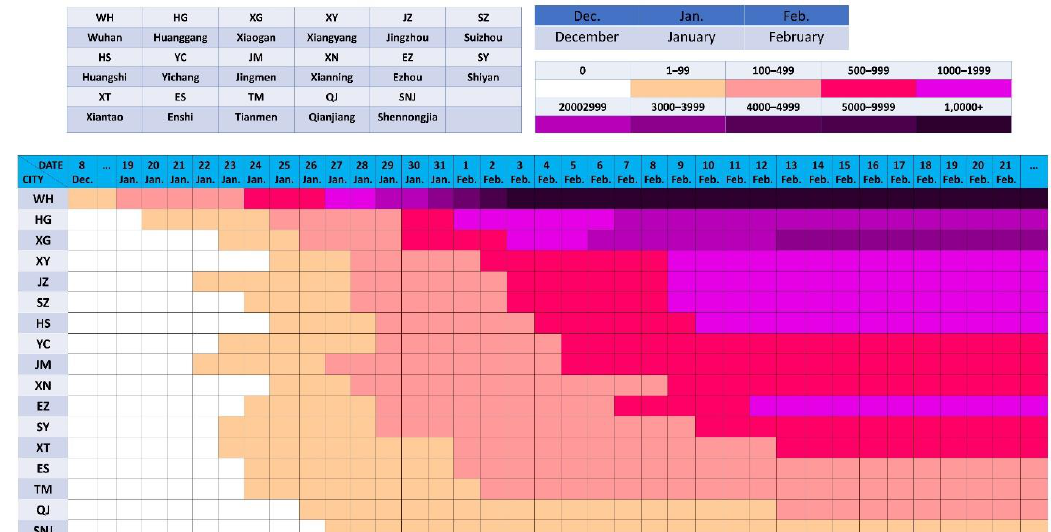
Figure 8. The time of the first reported cases and the following transmission situation in cities and prefectures in Hubei Province. In Hubei, there are cases in all cities and prefectures, and the order of appearance is related not only to the geographical location of Wuhan but also to the degree of connection.